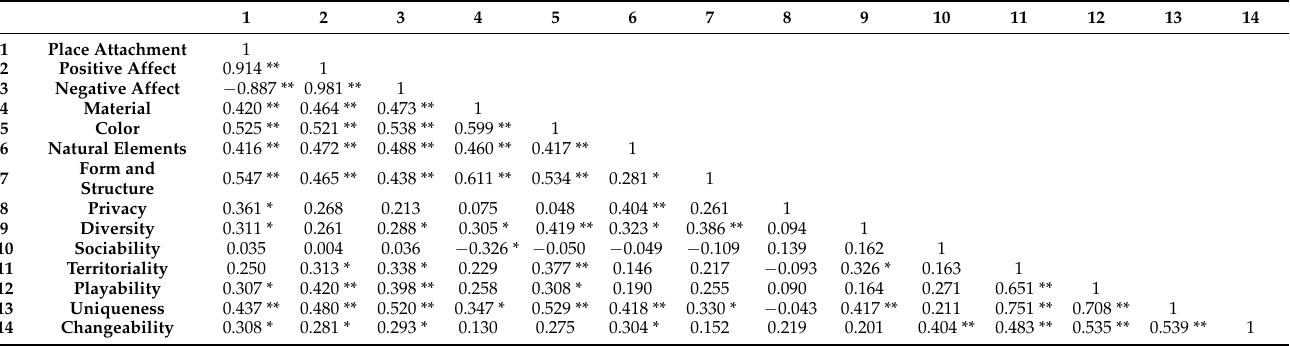
Table 5. Correlation coefficients between different attachment indicators of Xintiandi